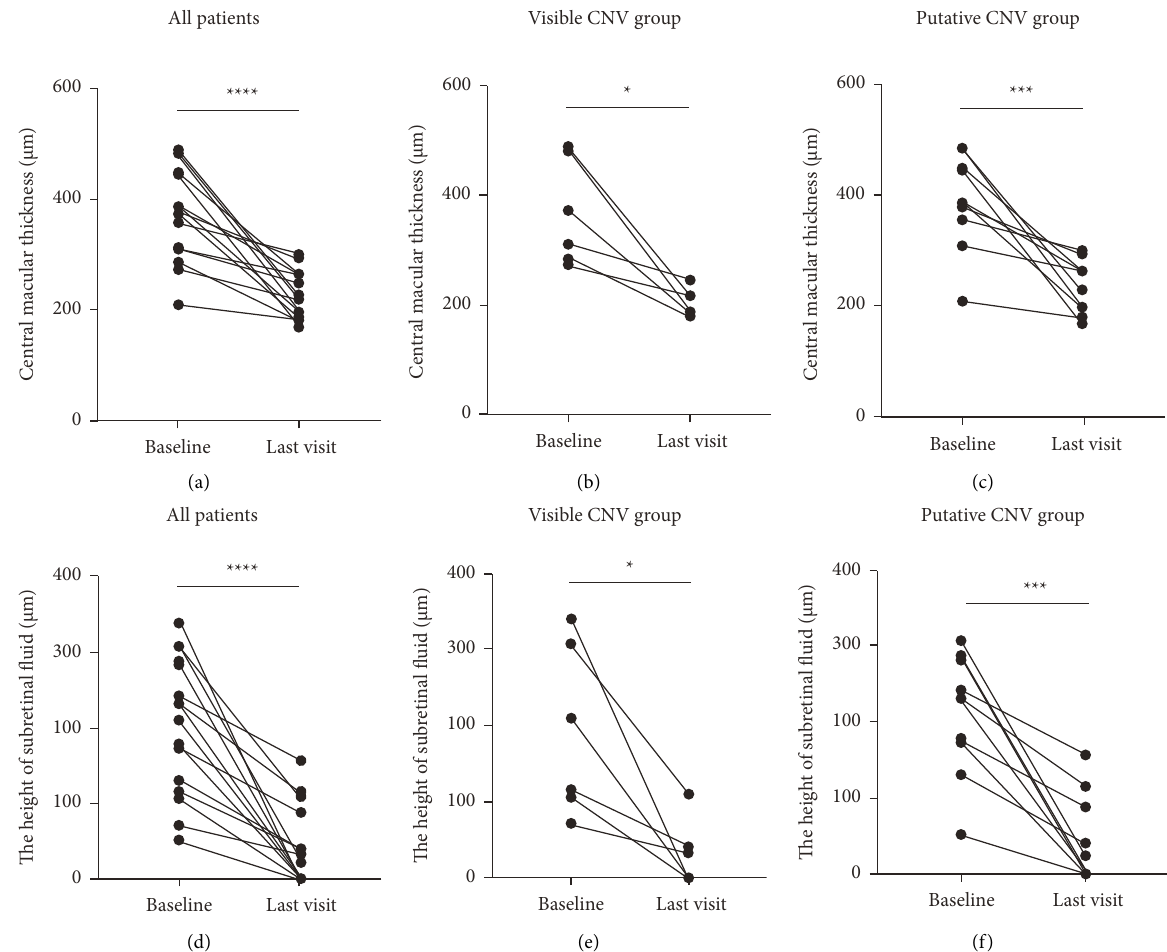
Figure 3: The quantitative analysis of CMTand SRF in CSCR patients with visible or putative CNV before and after anti-VEGF treatment. (a) The changes of CMTfor all the patients. (b) The changes of CMTin the visible CNV group. (c) The changes of CMTin the putative CNV group. (d) The changes of the height of SRF for all the patients. (e) The changes of the height of SRF in the visible CNV group. (f) The changes of the height of SRF in the putative CNV group. The data were represented as mean ± SD; CMT, central macular thickness; SRF, subretinal fluid. The statistics was analyzed by the paired t -test, ∗∗ P < 0 . 01, ∗∗∗ P < 0 . 001, and ∗∗∗ P < 0 .